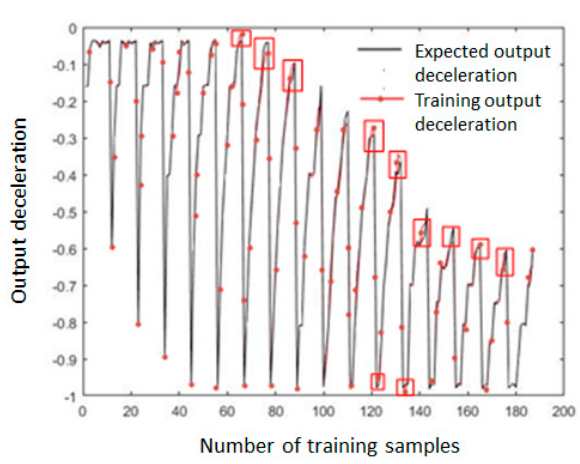
Figure 15. The variation trend of the total error.